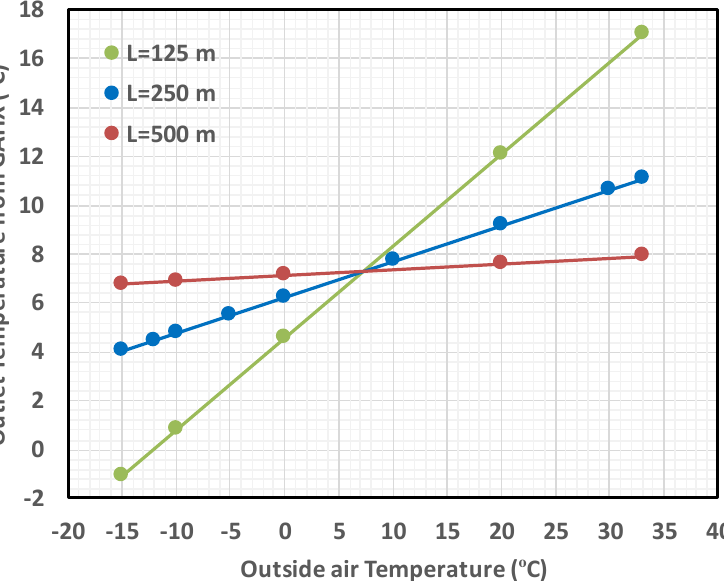
Figure 3. Outlet air temperature from GAHX at different outside temperatures and GAHX lengths. The AWHP performance data in terms of heat delivery and COP at different water inlet temperatures in the winter and summer seasons are presented in Figure 4. The AWHP performance at the inlet water temperature of 40 °C, 30 °C and 20 °C for the winter season and 10 °C and 15 °C for the summer season are modeled and presented. The results show that the heat transfer delivery from the AWHP increases with further increases in the outside air temperature during the winter period and decreases with the increase in the outside air temperature during the summer period, as presented in Figure 4a. In the winter period, the heat delivery from the AWHP increases by an average of 3% by de- creasing inlet water temperature from 30 °C to 20 °C and increasing by an average of 7% for further decreases in inlet water temperature from 40 °C to 30 °C. However, the heat delivery increases by an average of 16% by increasing the inlet water temperature from 10 °C to 15 °C in the summer period. On the other hand, the COP for AWHP increases by 7% with a further decrease in the inlet water temperature to the AWHP from 30 °C to 20 °C and increases by an average of 15% with decreasing the inlet water temperature from 40 °C to 30 °C in the winter season, as shown in Figure 4b. Whereas, in the summer season, the COP of the AWHP increases at a high inlet water temperature of 15 °C by an average of 11% compared to an inlet water temperature of 10 °C. ( a) Heat Delivery (b) COP Figure 4. AWHP heat delivery and COP at different outside temperatures and inlet water temperatures in winter and summer seasons ( a ) Heat Delivery and ( b ) COP.